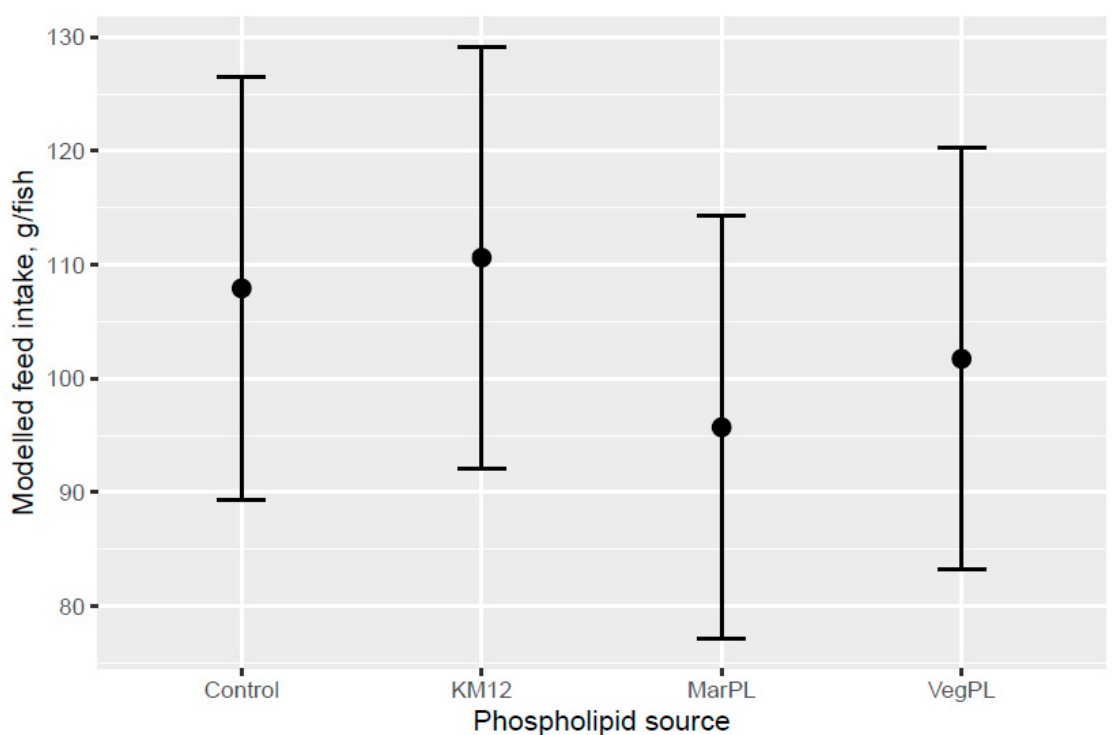
Figure 1. Modelled feed intake in relation to increasing KM inclusion after 53 d of feeding in the freshwater pre-transfer phase. Dots denote observed tank mean feed intake with error bars giving 95% credible intervals.